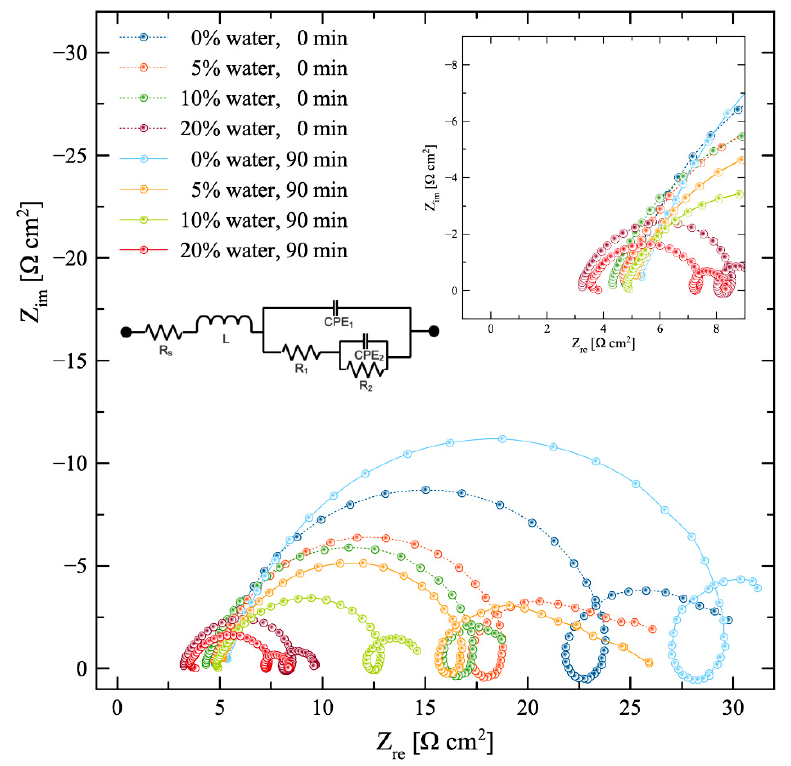
Figure 3. Nyquist plots of electrochemical impedance spectroscopy (EIS) of an Al electrode in methanol solutions containing 3 M KOH with different ratios of water (0%, 5%, 10%, and 20% (v/v)).